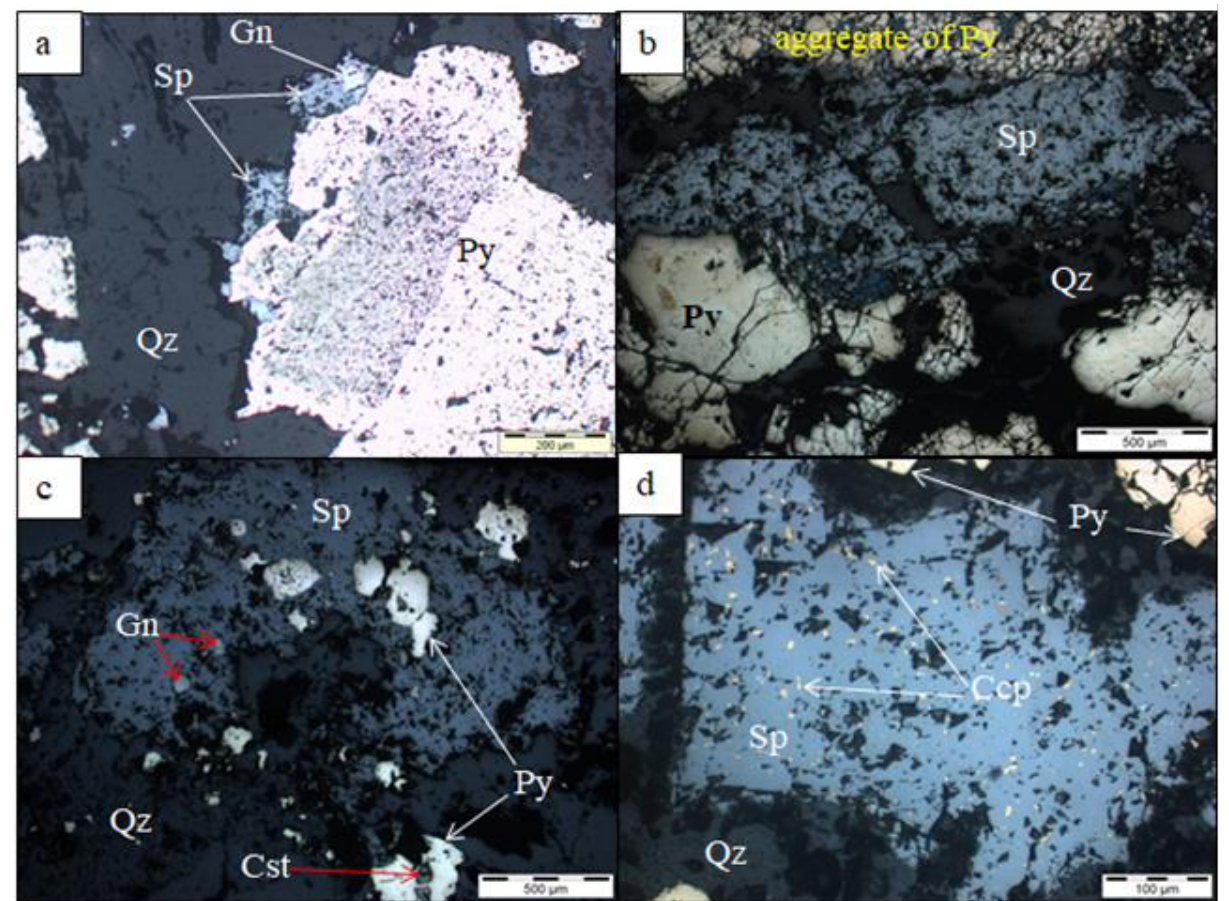
Figure 2. Reflected light photomicrographs showing petrographic aspects of sphalerite samples from Bukit Botol ( a – c ) and Bukit Ketaya ( d ). ( a ) The fine-grained sphalerite intergrown with galena are associated with overgrowths on pyrite and are most commonly abundant in the stringer zones; ( b ) The irregular-shaped sphalerite is up to 500 µm in size, intergrown with galena, pyrite and chalcopyrite; ( c ) Several inclusions of fine-grained, subhedral to rounded Sn-bearing minerals occur in this sphalerite, and are present in both massive and stringer mineralization; ( d ) Sphalerite exhibiting chalcopyrite disease showing irregular inclusions of chalcopyrite within sphalerite. Annotation: Ccp=chalcopyrite, Gn=galena, Sp=sphalerite, Cst=Sn mineral, Py=pyrite and Qz=quartz (according to [47]).